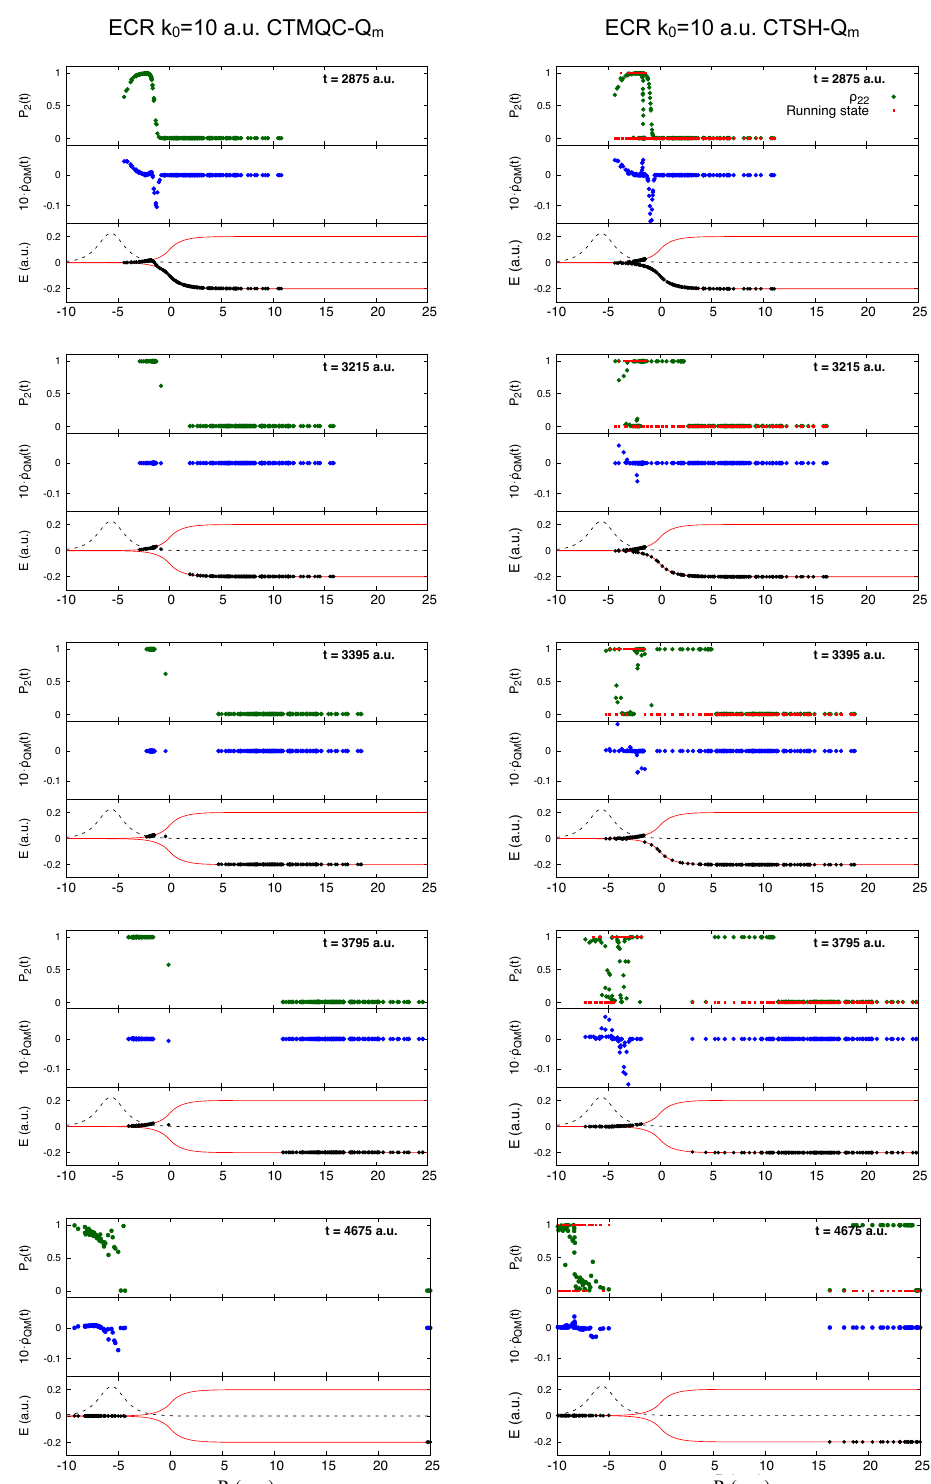
Figure 6. Top panels in each plot: Time snapshots of the electronic populations of the excited state for CTMQC ( left ) and CTSH ( right ), with the modified definition of the quantum momentum, at the positions of the trajectories (green dots) and running state (red dots). Middle panels in each plot: XF contribution to the time-variation of the electronic populations (blue dots), i.e., the second-term on the right-hand-side of Equation (24) but without the trajectory-sum. Lower panels in each plot: BO surfaces (thin red lines), NAC (thin dashed lines), and spatial distribution of the nuclear trajectories on the BO surfaces (black